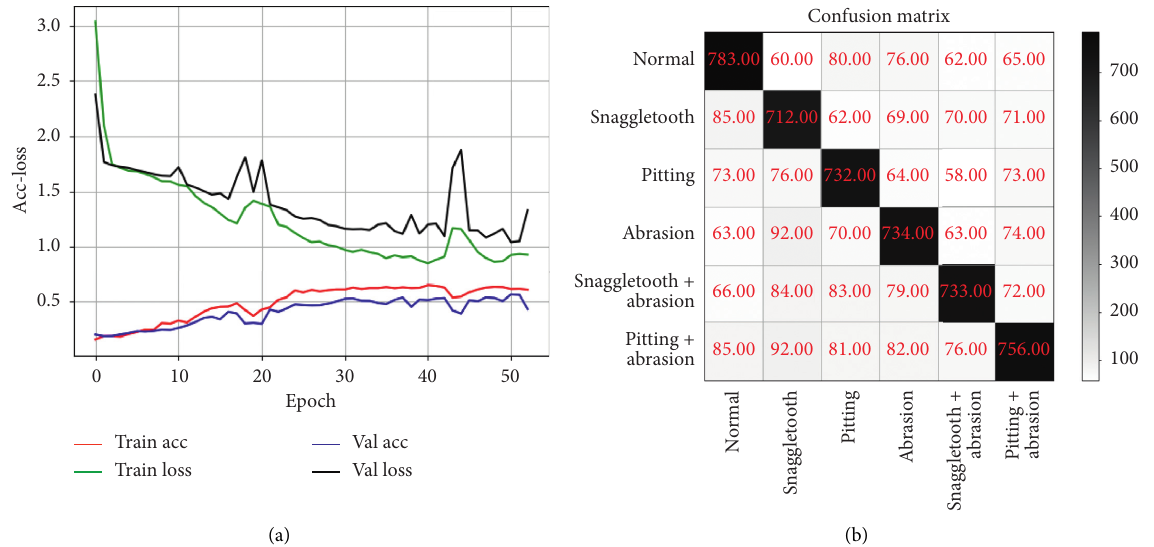
Figure 17: The 1-D CNN curve of accuracy rate and loss rate trained by IMF2 of EMD and confusion